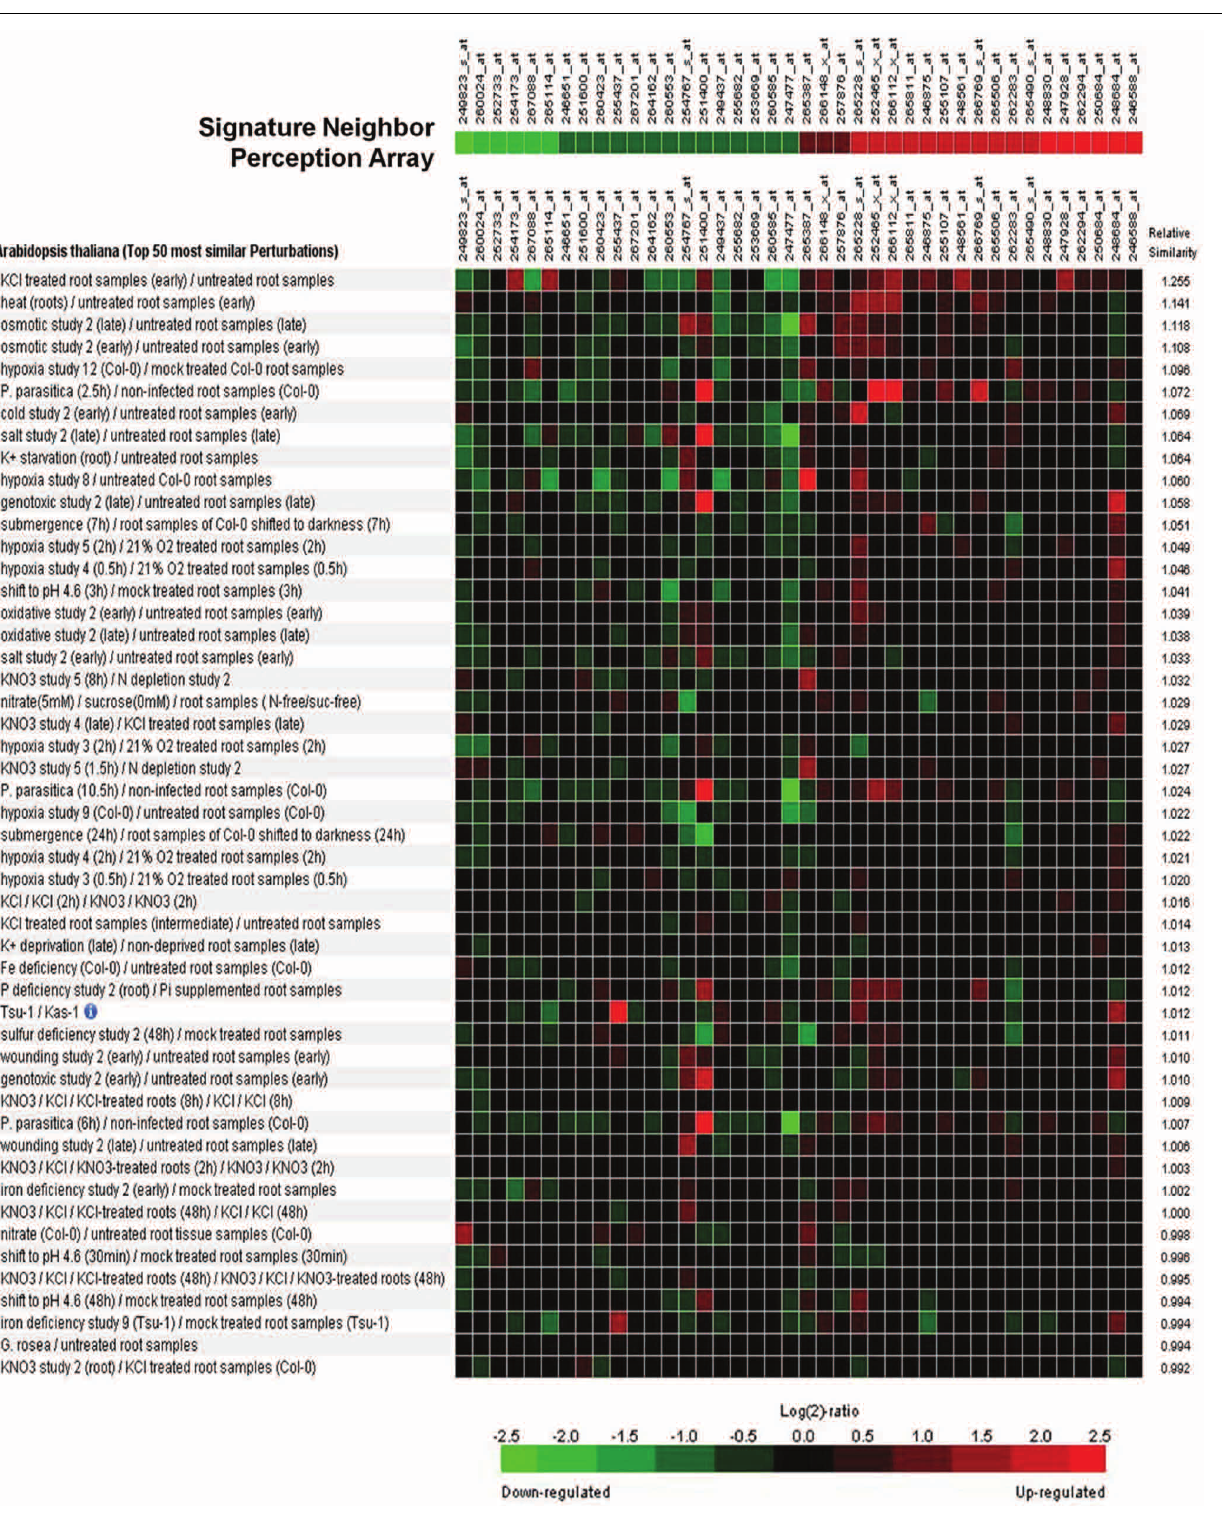
log2(mean signal ratio) were used to represent the neighbor-perception-array. The Genevestigator database was narrowed down to include solely studies in lateral roots of Arabidopsis wildtype, resulting in a total of 537 transcriptome studies. Green squares represent repression of the according gene in a particular array study, red squares represent